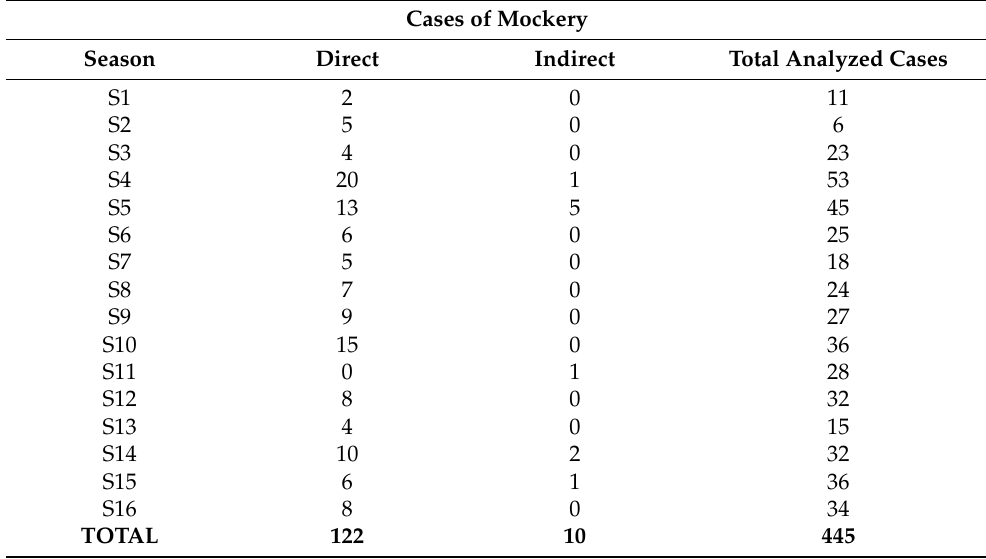
Table 3. Cases of mockery in Family Guy